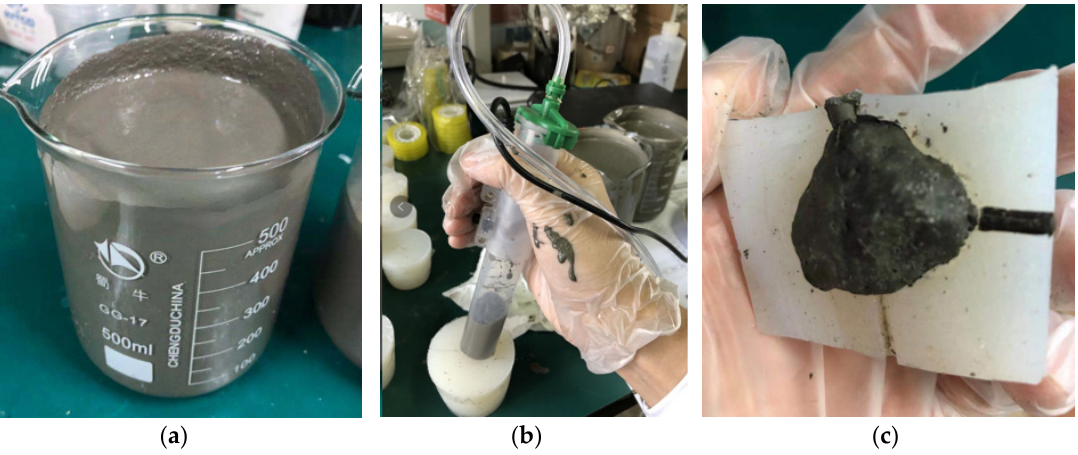
Figure 12. Mold grouting ( a ): preparation of cement mortar; ( b ): mortar injection; ( c ) Demolding.